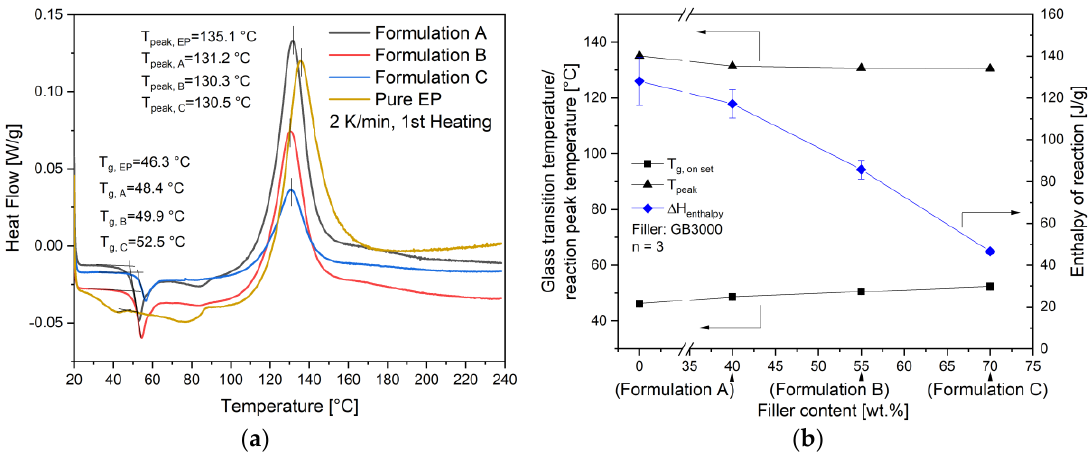
Figure 8. ( a ) The representative DSC dynamic measurement curves of formulations with the same filler size, but different filler contents, ( b ) Influence of filler content on the glass transition temperature T g , the reaction peak temperature T peak and the enthalpy of reaction ΔH total of compounds.